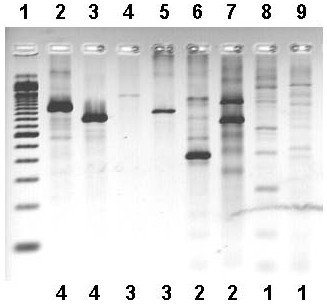
Examples of PCR results ascribed to subjective rankings used for cross-species amplifications shown in Table 3. Lane numbers and subjective rankings appear above and below the picture, respectively. Lane 1, 100 bp ladder (Invitrogen Corp.); lanes 2 and 3, "4" ranking (lane 2, MACF1 monkey; lane 3, MACF1 dog); lanes 4 and 5, "3" ranking (lane 4, GNB1 mouse; lane 5, ORC4L cat); lanes 6 and 7, "2" ranking (lane 6, DVL1 goat; lane 7, CDC7 hamster); lanes 8 and 9, "1" ranking (lane 8, DVL1 monkey; lane 9, DVL1 pig). Ranking numbers are also provided below each lane. A ranking of "0" signifies that no bands of any kind were seen (not shown).